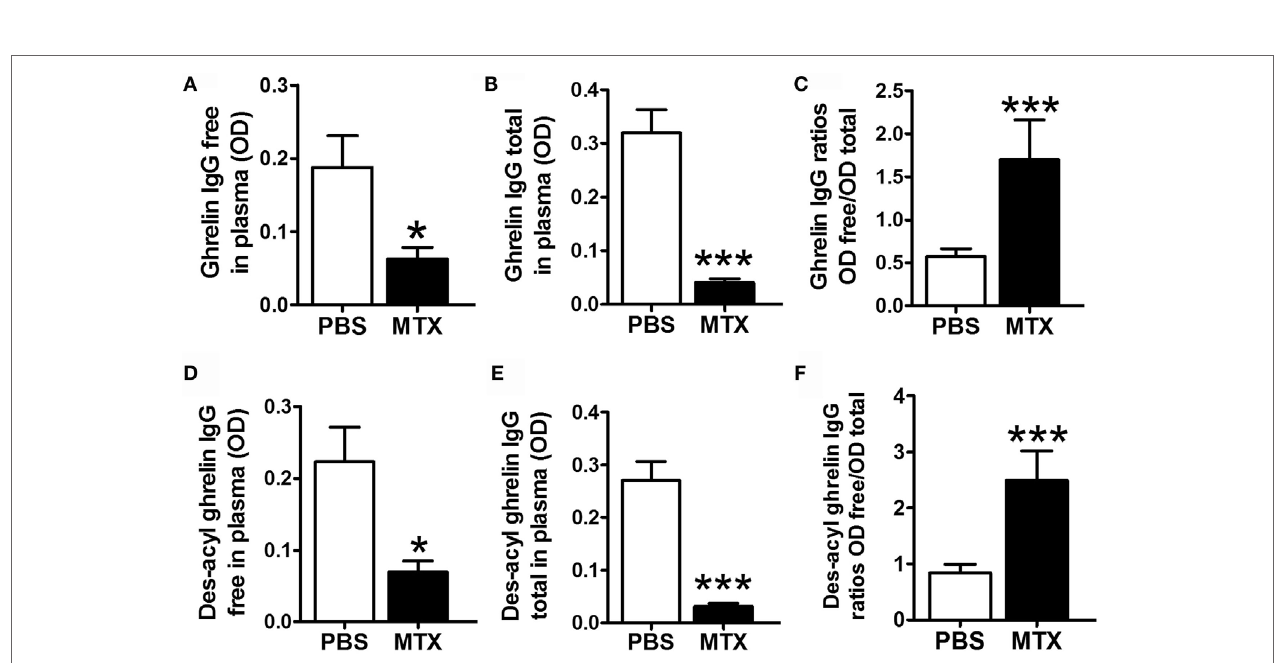
FigUre 4 | Plasma concentrations of free (a,D) and total (B,e) igg reactive with ghrelin (a,B) and des-acyl ghrelin (D,e) in MTX-treated ( n = 10) and PBs-treated control rats ( n = 10) . Mann–Whitney or Student’s t -test (a,e) according to the KS normality tests, * p < 0.05, ** p < 0.01, *** p < 0.001. KS tests, (a) p > 0.1 and p = 0.08, (B) p > 0.1 and p = 0.03, (c) p > 0.1 and p = 0.003, (D) p > 0.1 and p = 0.005, (e) p > 0.1 and p = 0.1, (F) p > 0.1 and p = 0.006 (mean ± SEM).